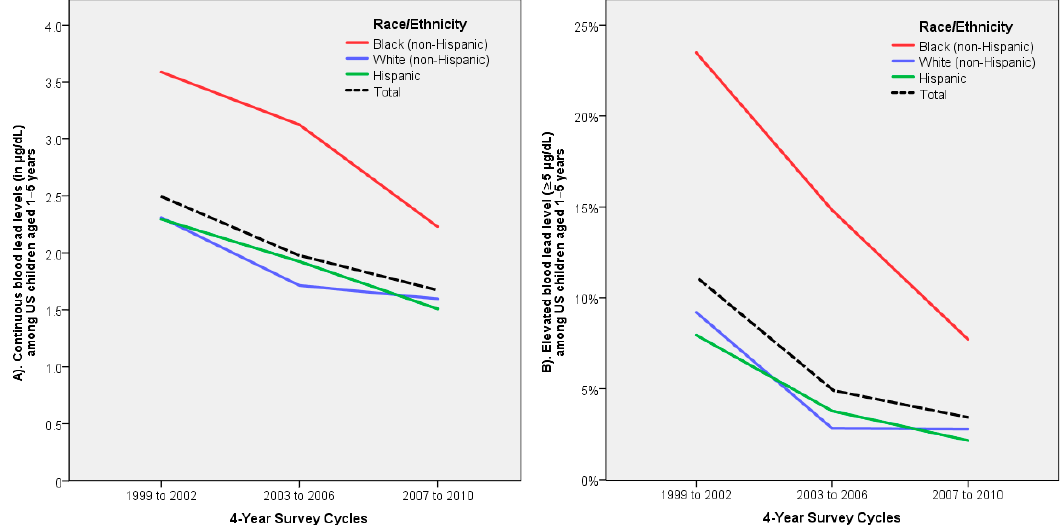
Figure 4. Weighted estimates of means for ( A ) continuous blood lead levels (BLLs) or ( B ) rates of elevated BLLs (EBLLs) ≥ 5 µg/dL among US children 1–5 years of age with US citizenship—the 1999 to 2010 NHANES.